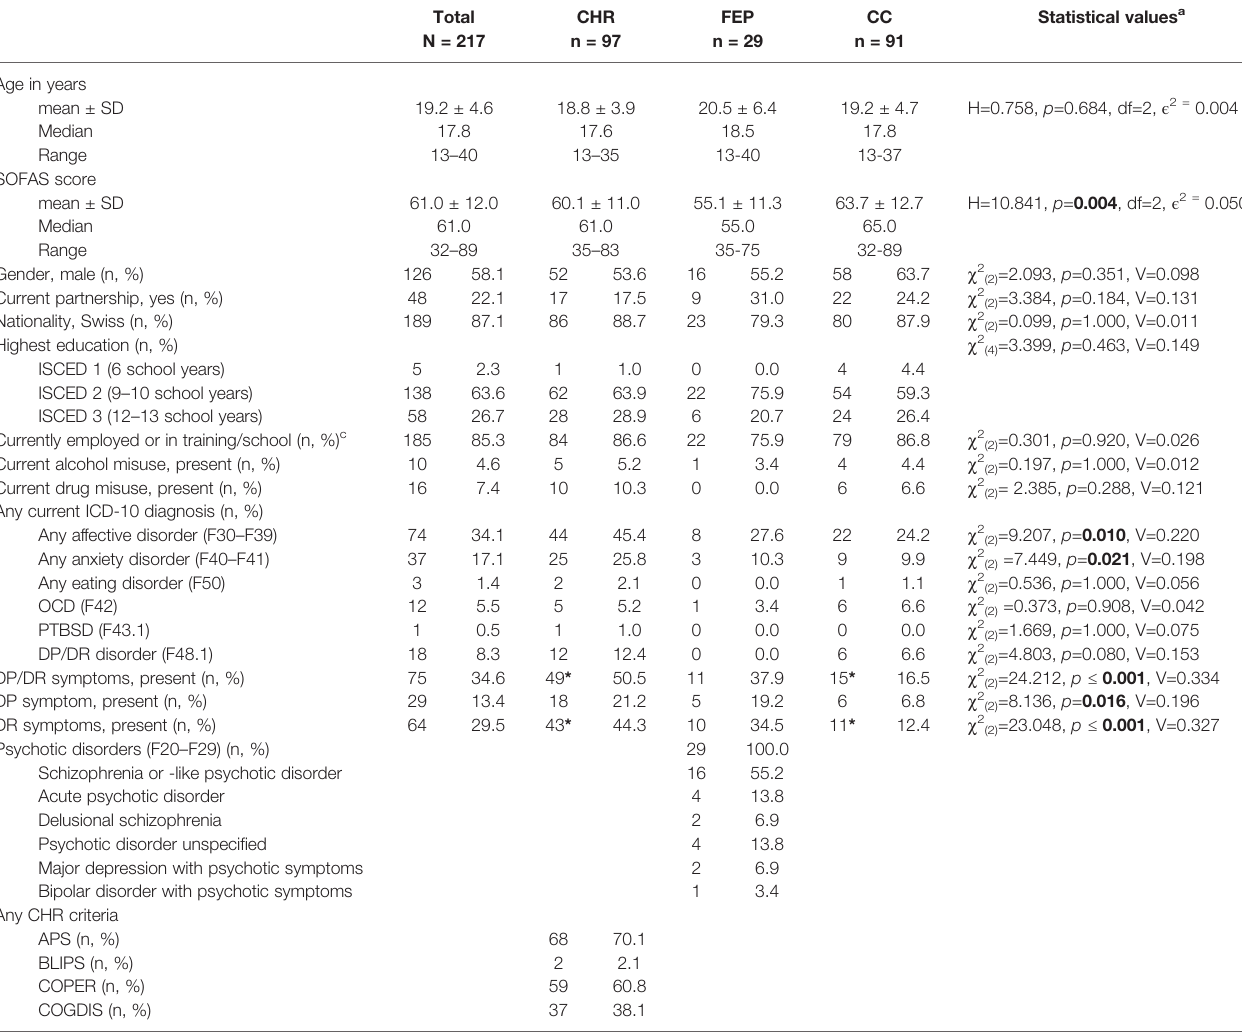
TABLE 1 | Sociodemographic and clinical characteristics of the complete sample 1 (CHR, FEP, CC). Total